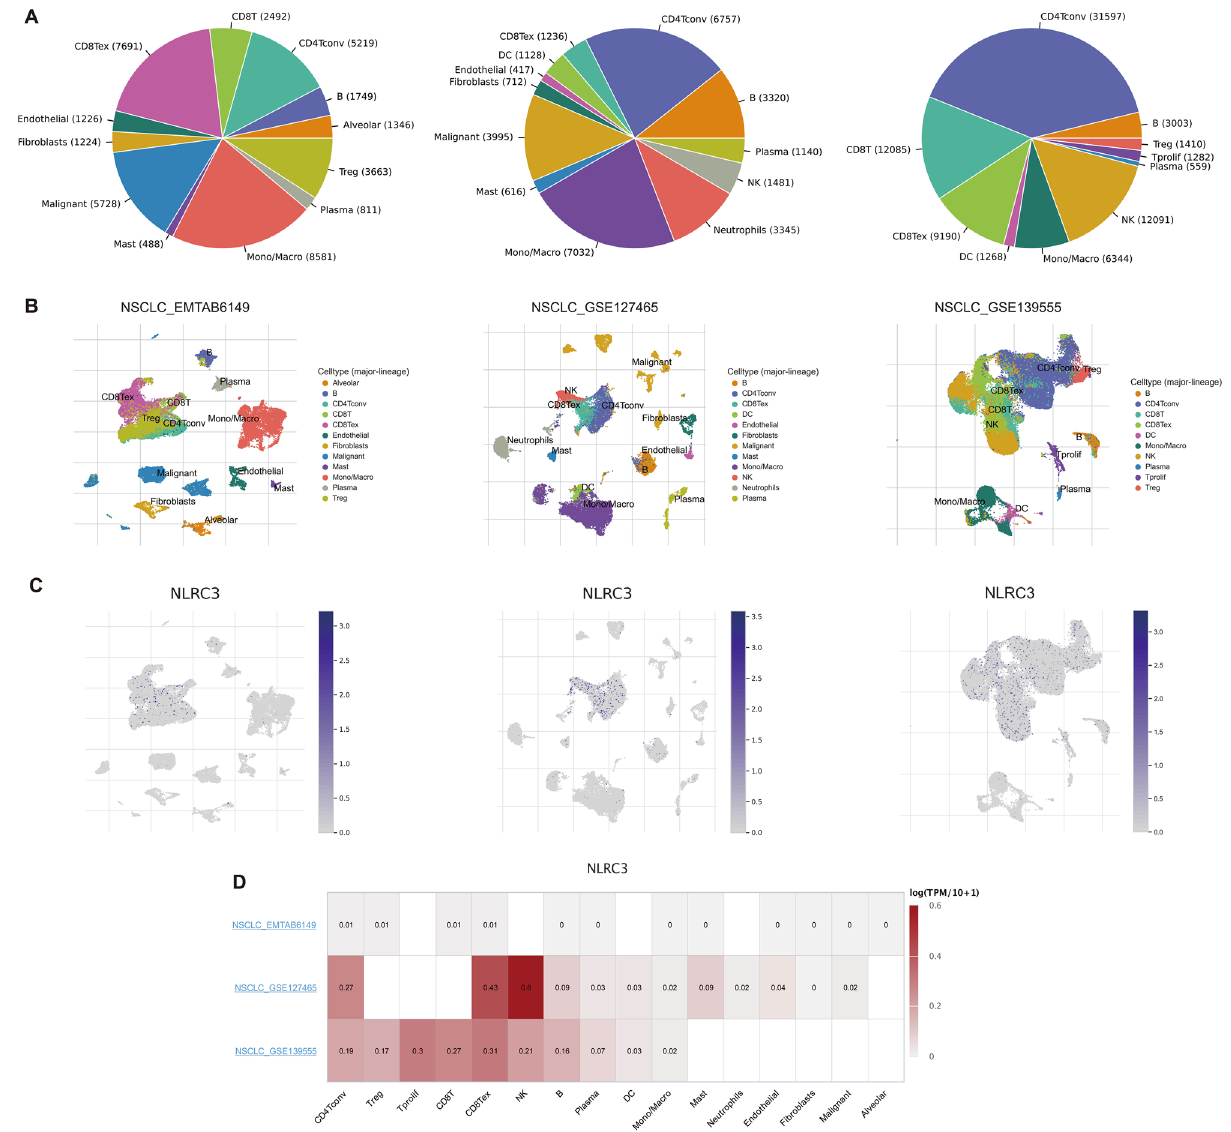
Figure 4. Correlation between NLRC3 expression and the tumor microenvironment using the TISCH database. ( A ) The cell types and their distributions in the NSCLC_EMTAB6149, NSCLC_GSE127465, and NSCLC_ GSE139555 datasets. ( B , C ) Distribution of NLRC3 across different cells in the NSCLC_EMTAB6149, NSCLC_ GSE127465, and NSCLC_GSE139555 datasets. ( D ) The heatmap displays the value of NLRC3 expression in different cells from different